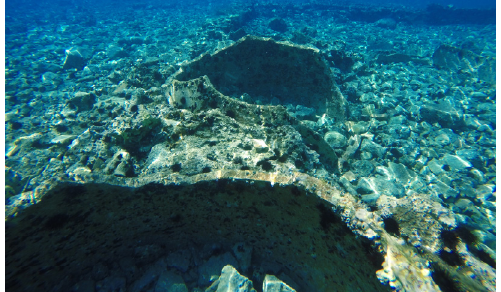
Figure 4: The storage room of the villa with the jars.